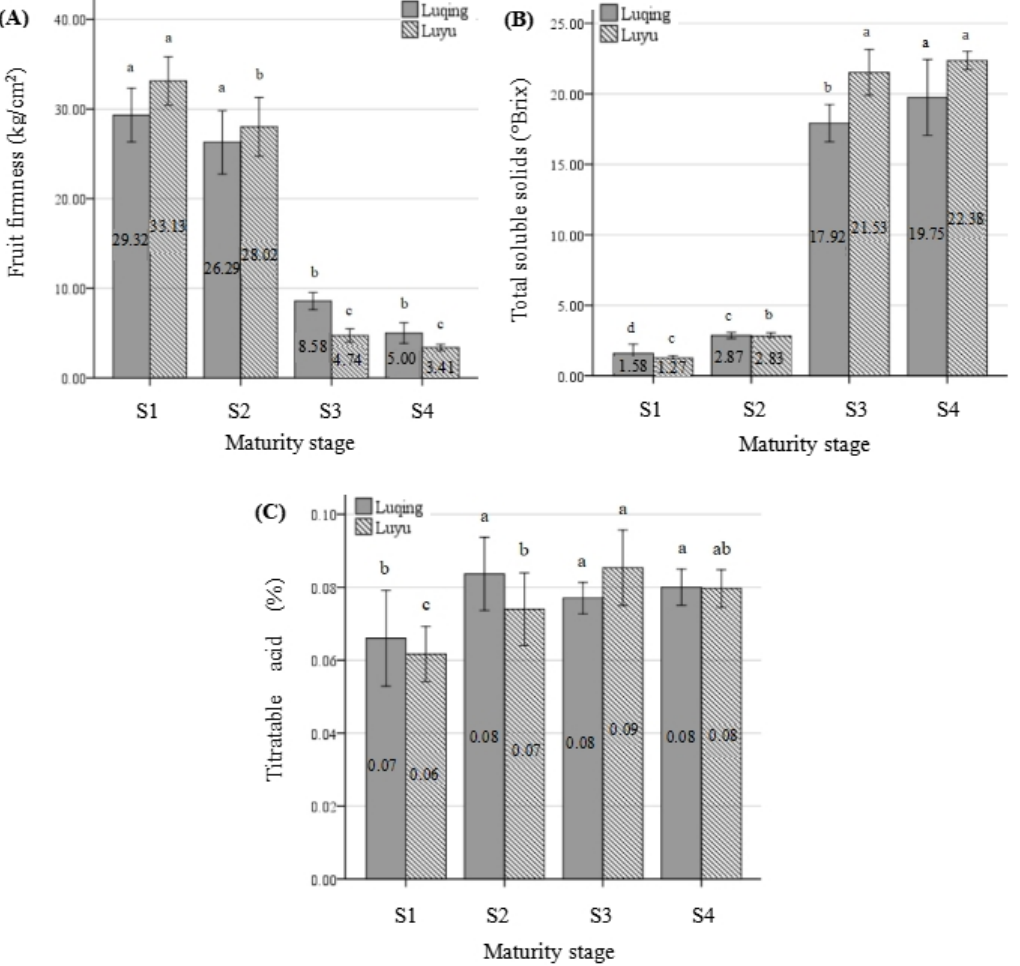
Figure 2 . Fruit firmness (A), total soluble solids (B), and titratable acidity (C) in Akebia trifoliata fruit at four stages of ripening. Error bars indicate standard error from 10 replicates. Means with different letters within each clonal line indicate statistical differences at the p < 0.05 level using the LSD test. S1: 120 days after full bloom (DAFB), S2: 134 DAFB, S3: 148 DAFB, S4: 155 DAFB.